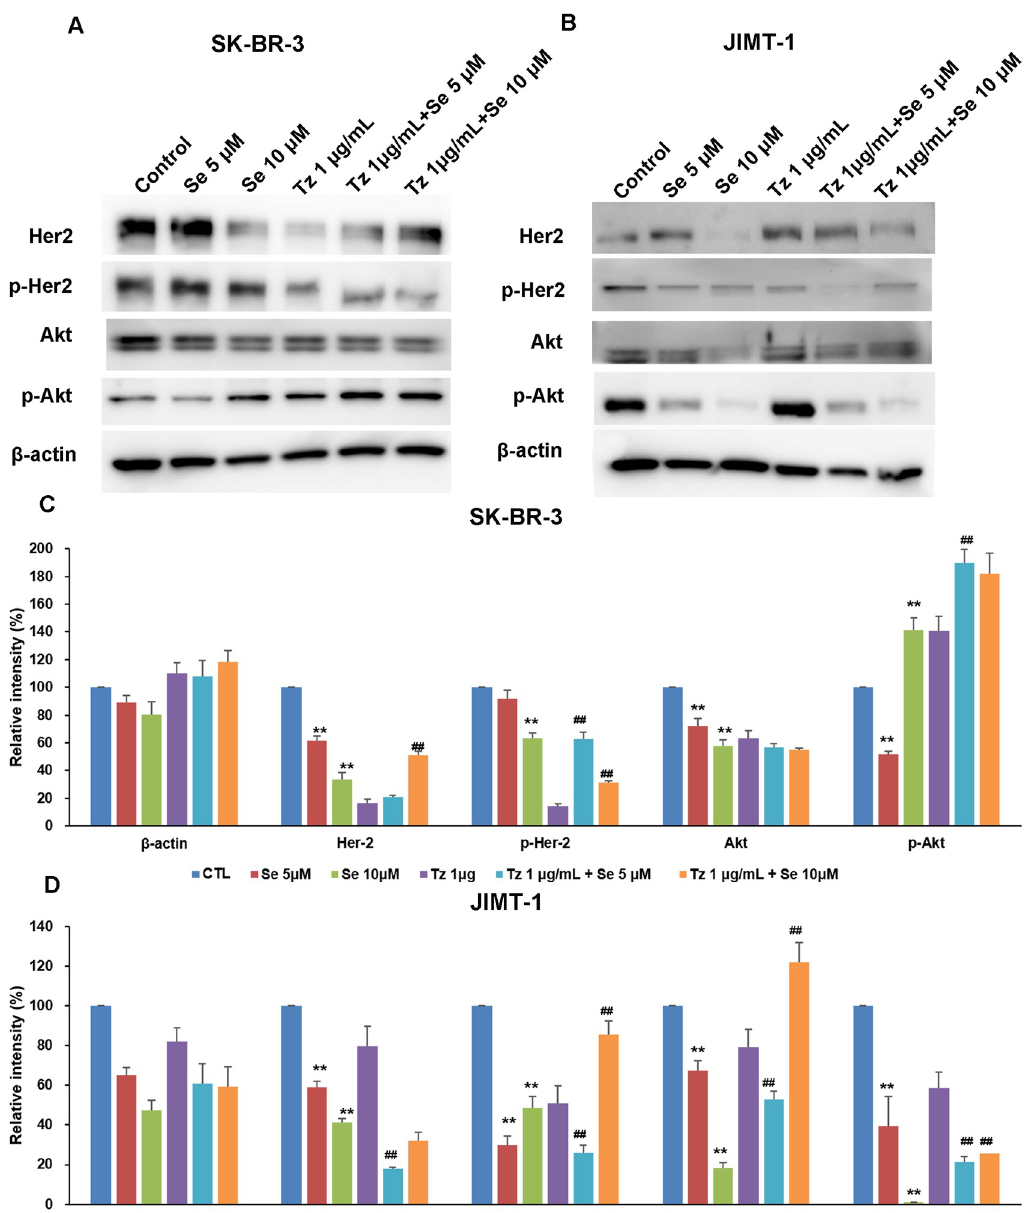
Fig 4. Changes in Her2 and Akt in Tz-sensitive (A, C) and -resistant (B, D) breast cancer cells. The data are presented as Her2, p-Her2, Akt, and p-Akt expressed relative to control after treatment of Se, Tz, and combinations of both drugs for 72 h by Western blot analysis and densitometry analysis. Similar results were observed in replicate experiments. Protein expression levels (relative to β -actin) were determined. One-way ANOVA followed by post Scheffe test was used for statistical analysis to compare between groups. ( � P < 0.05; �� P < 0.01 significantly different from control; # P < 0.05; ## P < 0.01 significantly different from Tz single treatment). Effects of Se on Her-2 and Akt in SK-BR-3 and JIMT-1 were opposed to each other.